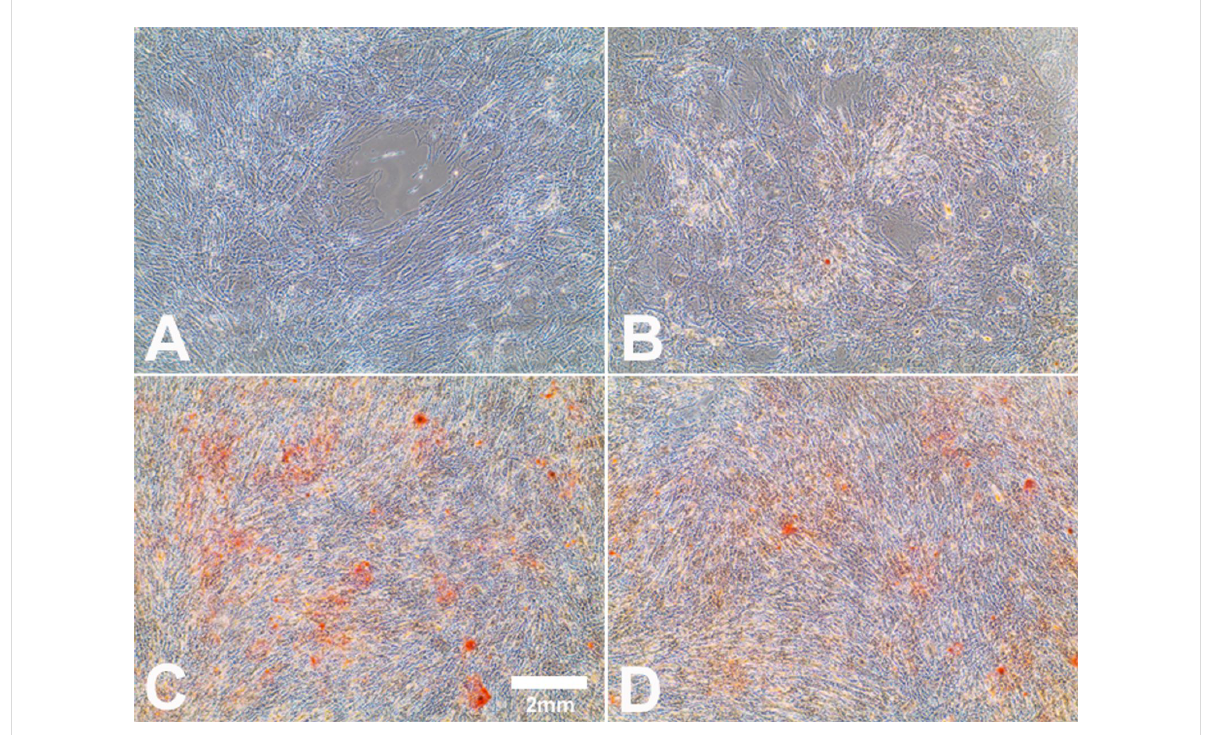
Figure 6: Influence of Ag-NP/ Ag + ions on hMSCs during osteogenic differentiation. After 21 d of cell culture (bright-field images), staining with alizarin red S was used to visualize calcium accretion in cells cultured under osteogenic conditions. hMSCs incubated in the presence of osteogenic-differenti- ation media served as the positive control (C). hMSCs incubated in the presence of RPMI/FCS served as the negative control (A). hMSCs incubated with 10 µg·mL − 1 Ag-NP (B) or with 1.0 µg·mL − 1 Ag + ions (D) for 24 h, and followed by osteogenic-differentiation media for a further 21 d.